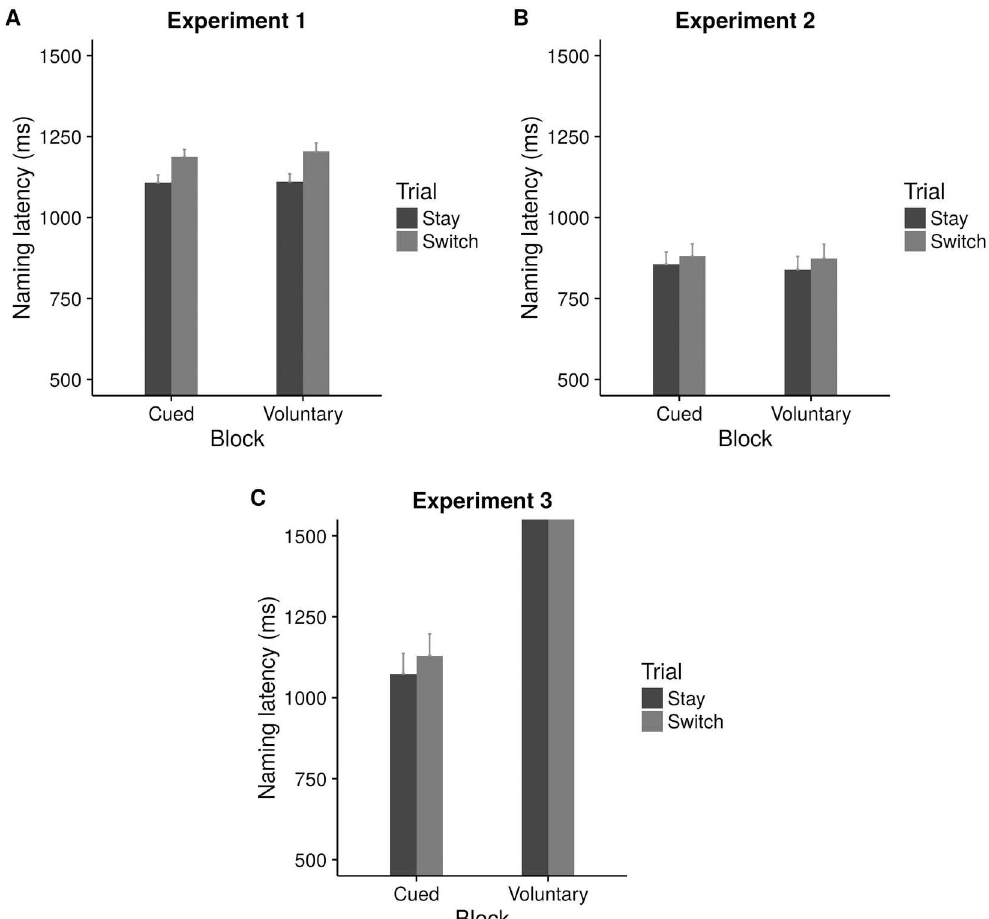
Fig 5. Naming latency on stay and switch trials on cued and voluntary blocks (Expt.